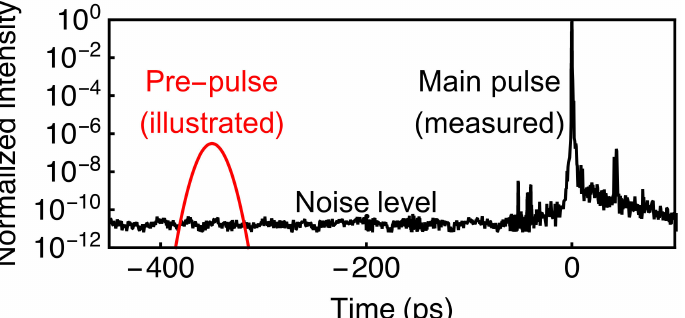
Figure 1. The temporal profile of the NePTUN laser system (black), measured with a Sequoia third- order auto-correlator [34]. The 10 − 10 background is the diagnostic noise level, forming a lower limit at t = − 50 ps. The auxiliary pre-pulse is illustrated in